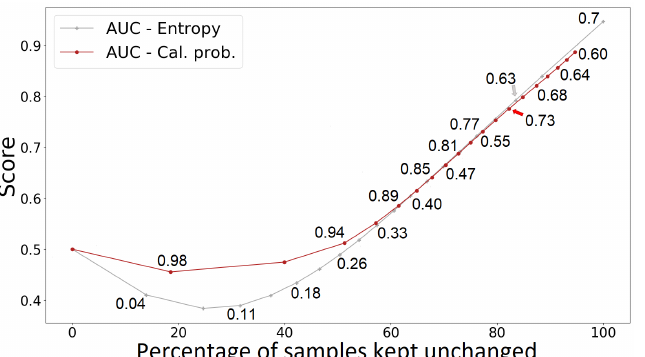
Figure 9. AUC score vs. Percentage of samples kept unchanged for uncertainty selection on ESDB dataset. Each curve shows the corresponding threshold values used for the data points. The original model is WiderNet 8 × , FCN 128 with Bayesian approach. Best viewed in